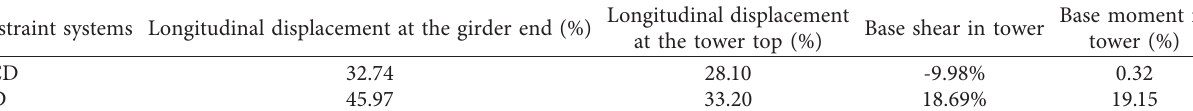
Table 4: Comparison of seismic mitigation ratios with different measures.